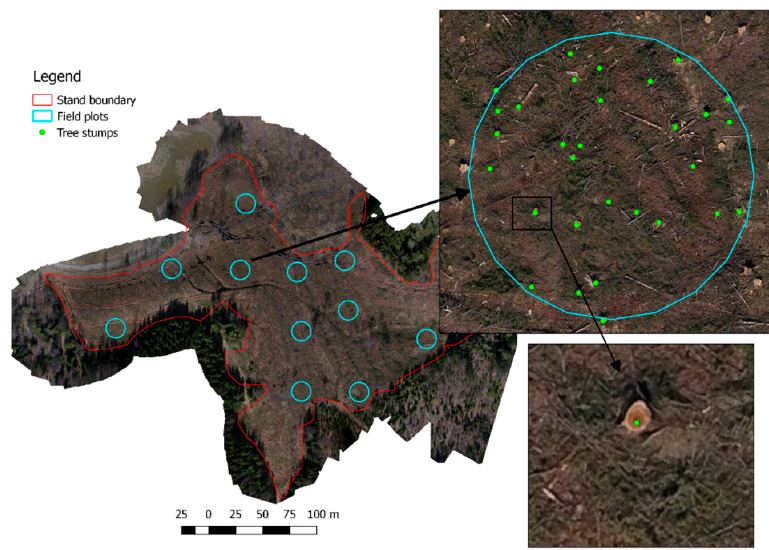
Figure 1. Overview of the sampling design for field data acquisition with a detail on a single field plot. The orthomosaic displayed in the background was the one derived from the Unmanned Aerial Vehicles (UAV) photogrammetric processing (i.e., ground sampling distance = 1.7 cm).